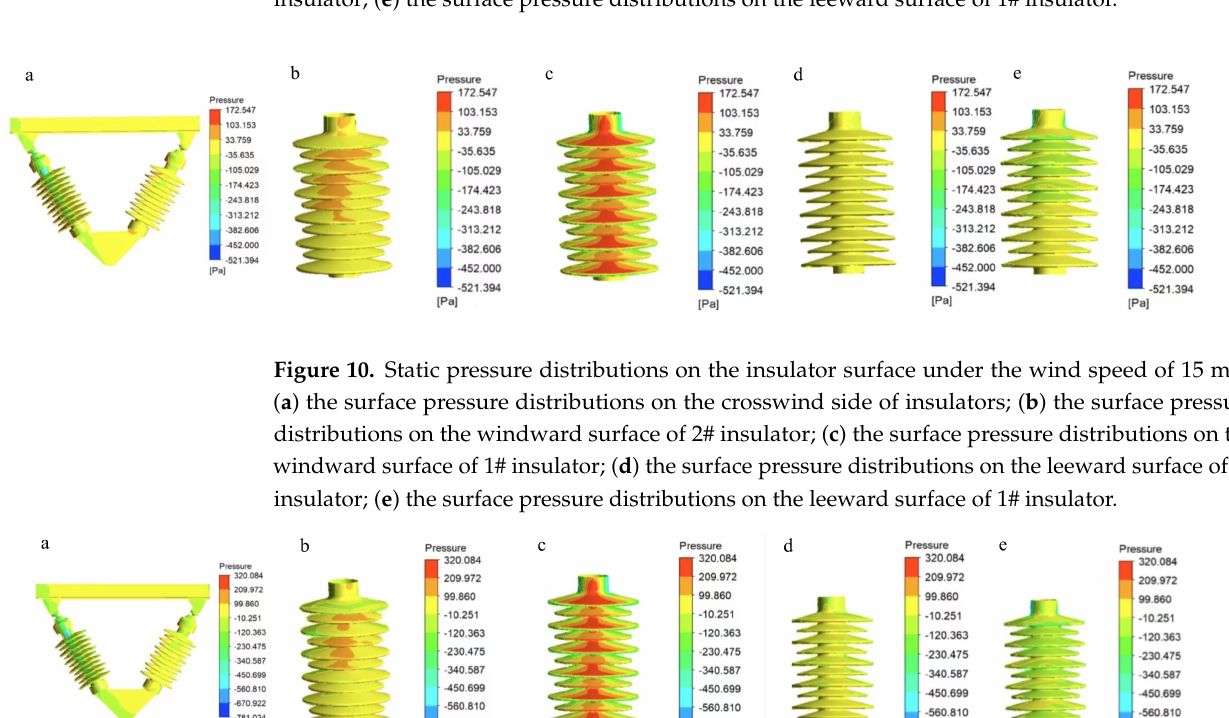
Figure 9. Static pressure distributions on the insulator surface under the wind speed of 10 m/s. ( a ) the surface pressure distributions on the crosswind side of insulators; ( b ) the surface pressure distributions on the windward surface of # insulator; ( c ) the surface pressure distributions on the windward surface of 1# insulator; ( d ) the surface pressure distributions on the leeward surface of 2# insulator; ( e ) the surface pressure distributions on the leeward surface of 1# insulator.